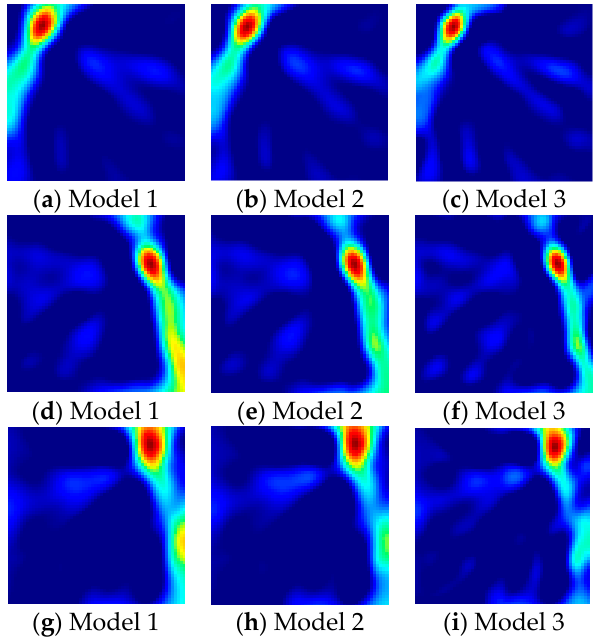
Figure 7. Reconstructed images by Three Models. ( a – i